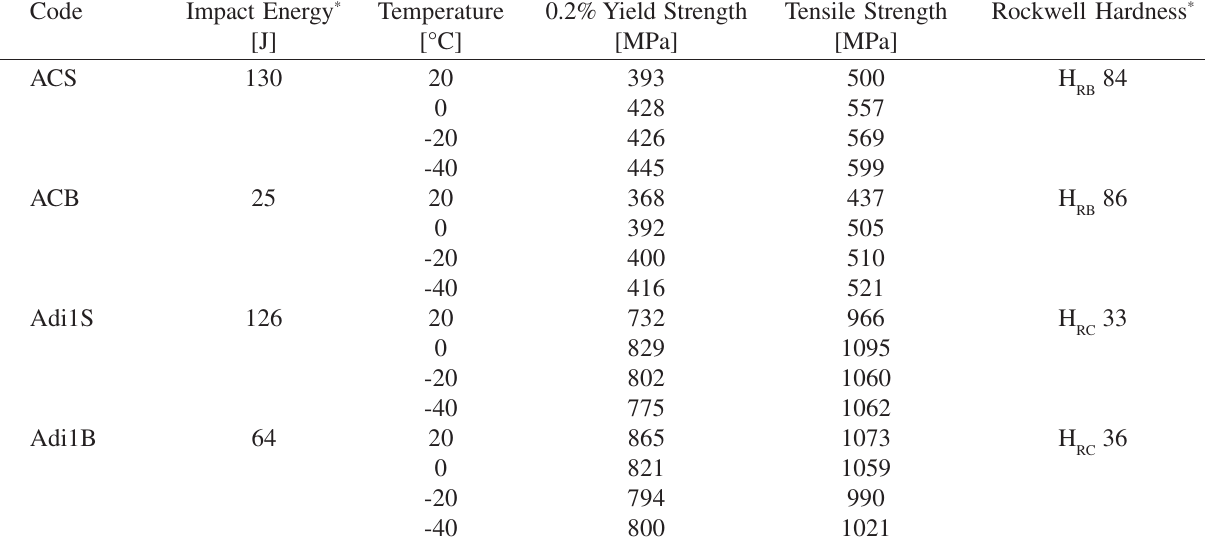
Table 4. Mechanical properties (average values of four measurements). * Measurements at 20 °C. The scattering around the mean values of tension and yield strength are less than 5% for the as-cast samples and less than 10% for the ADI samples.